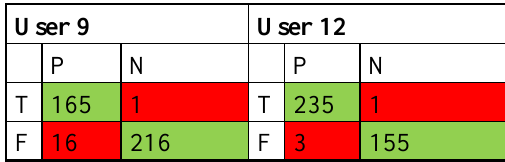
Table 13. SCR confusion matrix for Stroop test II.